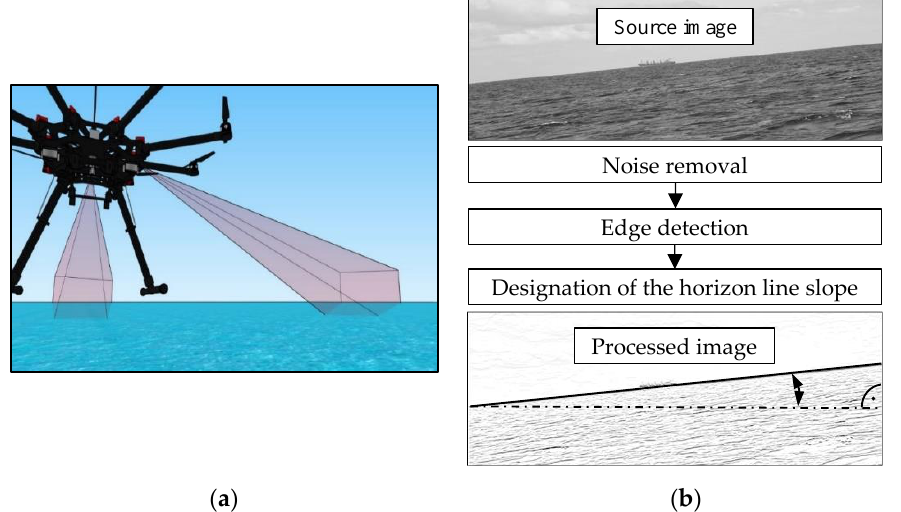
Figure 1. The idea of measuring the horizon line slope: ( a ) Recording images with a two-camera tilt compensator mounted on a UAV; ( b ) The image processing process for the slope angle.